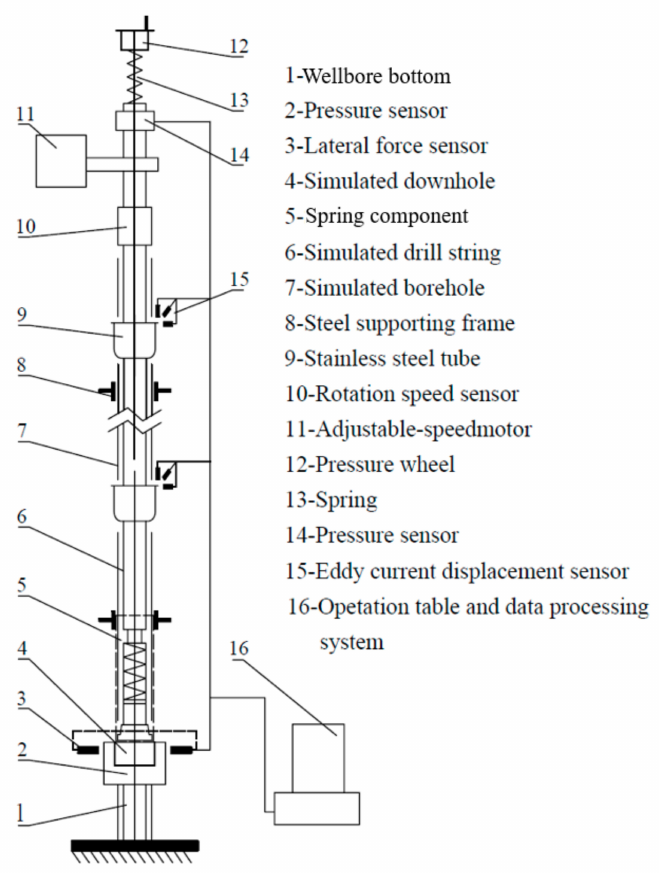
Figure 2. The general structure of the experimental device.